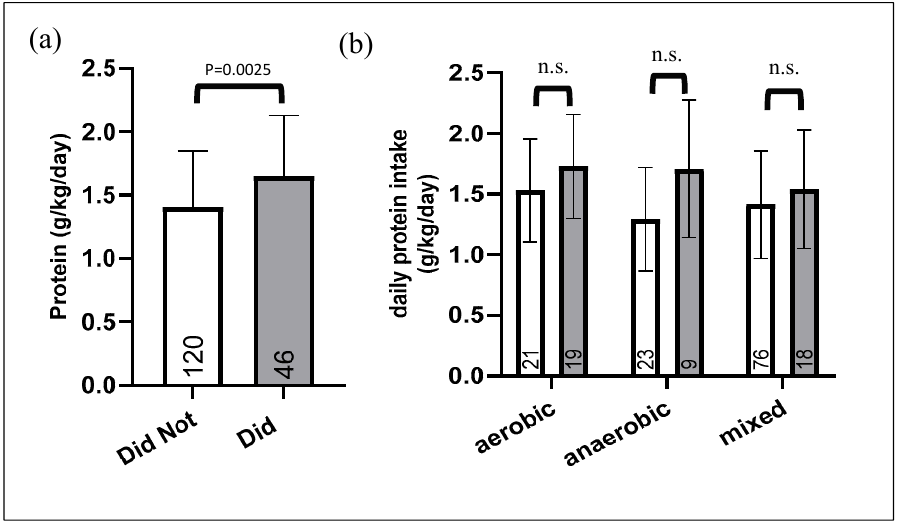
Figure 1. Daily protein intake from food-only among those who supplement and those who do not. ( a ) Bar graph of protein intake (excluding supplements) subdivided by those who did not supplement and those who did. Numbers inside the bars represent number of subjects. ( b ) Graphical representation of the e ff ect of sport type and of an athlete’s choice to take protein supplements on daily protein intake. White bars are the athletes who did not take supplements. Gray bar are the athletes who did chose to take supplements, but data is excluding protein from supplements. Numbers inside the bars represent number of subjects. Two-way ANOVA showed a population dependent di ff erence (F (1, 160) = 8.454, p = 0.0042), meaning that individuals who decided to take supplements were statistically di ff erent from those who did not take supplements in their daily protein intake. Sidak’s multiple comparisons test did not show any significant di ff erences in each sport group, n.s. = not significant.